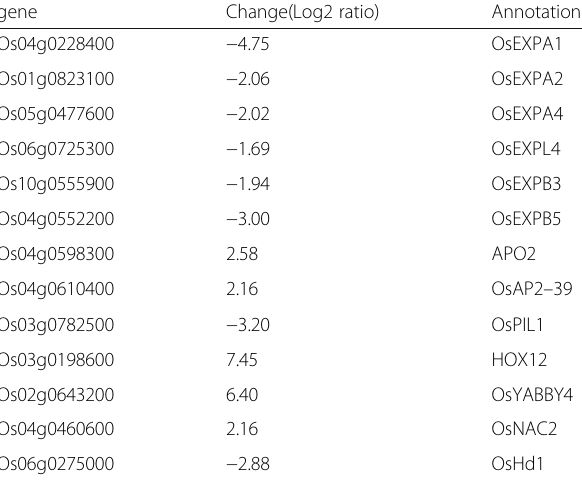
Table 1 Expression of genes involved in GA metabolism and cell wall loosening in osmads57 – 2 plants gene Change(Log2 ratio)